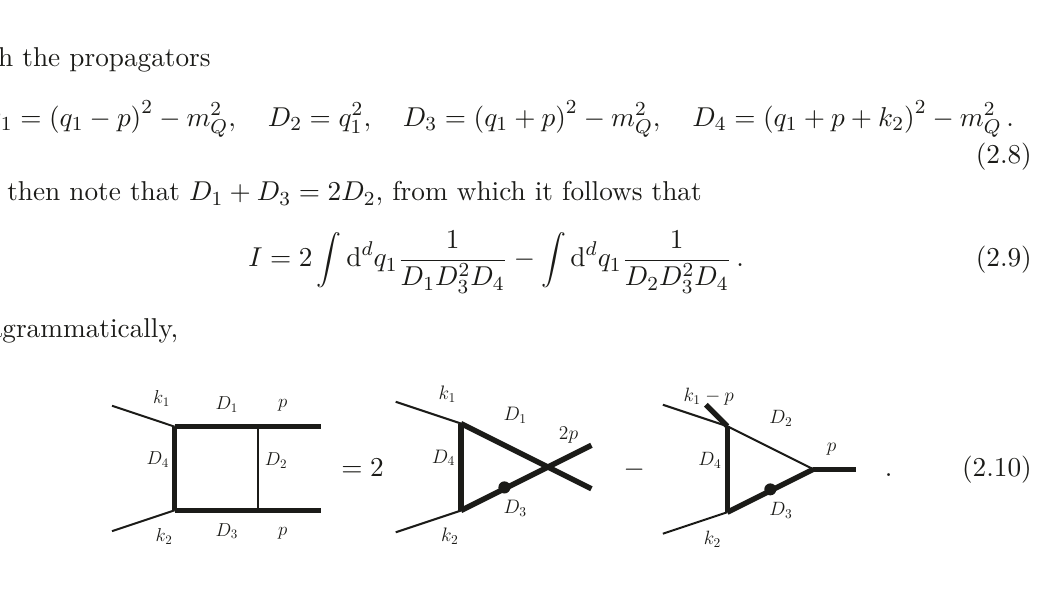
Figure 1. Four-point non-factorisable two-loop integrals. Thin lines are massless, and thick lines have mass m Q . A dot on a propagator means that the propagator is